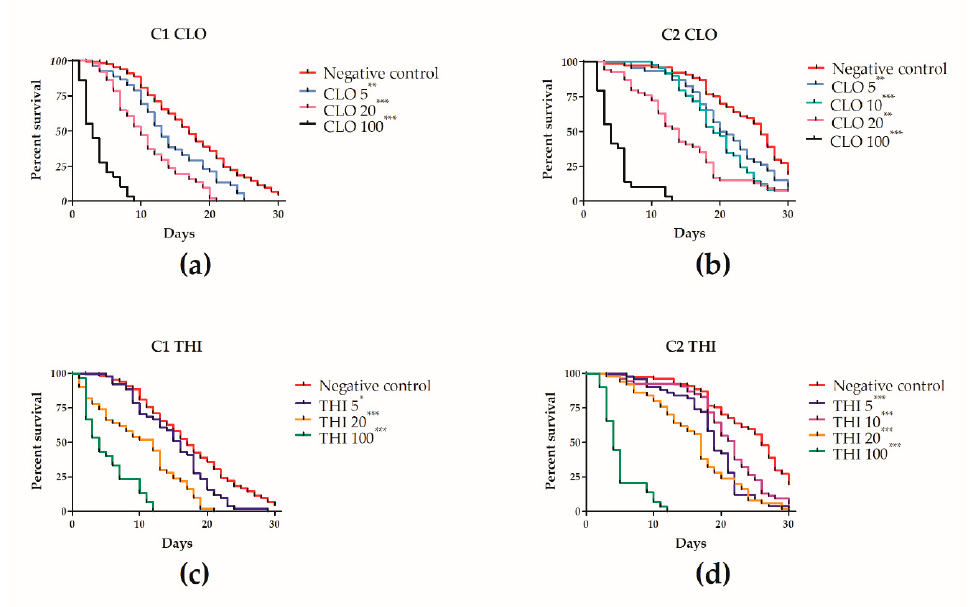
Figure 8. Chronic laboratory thiamethoxam or clothianidin exposure significantly decreases winter adult worker Apis mellifera survival. Winter workers were exposed to thiamethoxam (THI) or clothianidin (CLO) (doses in ng/g) for 30 days, through syrup, and mortality was monitored daily. Two laboratory cage trials were conducted: C1 in March–April ( a , c ) and C2 in April–May ( b , d ). Only C2 included 10 ng/g dose groups. Lines indicate percent daily survival for 131 ( a , c ) to 77 ( b , d ) bees in the negative control groups; 29–30 bees in the 100 ng/g groups; and 46–54 bees in the other treatment groups. *, **, *** survival significantly different from control, p < 0.05, 0.01, 0.001, by a Weibull accelerated failure time model.